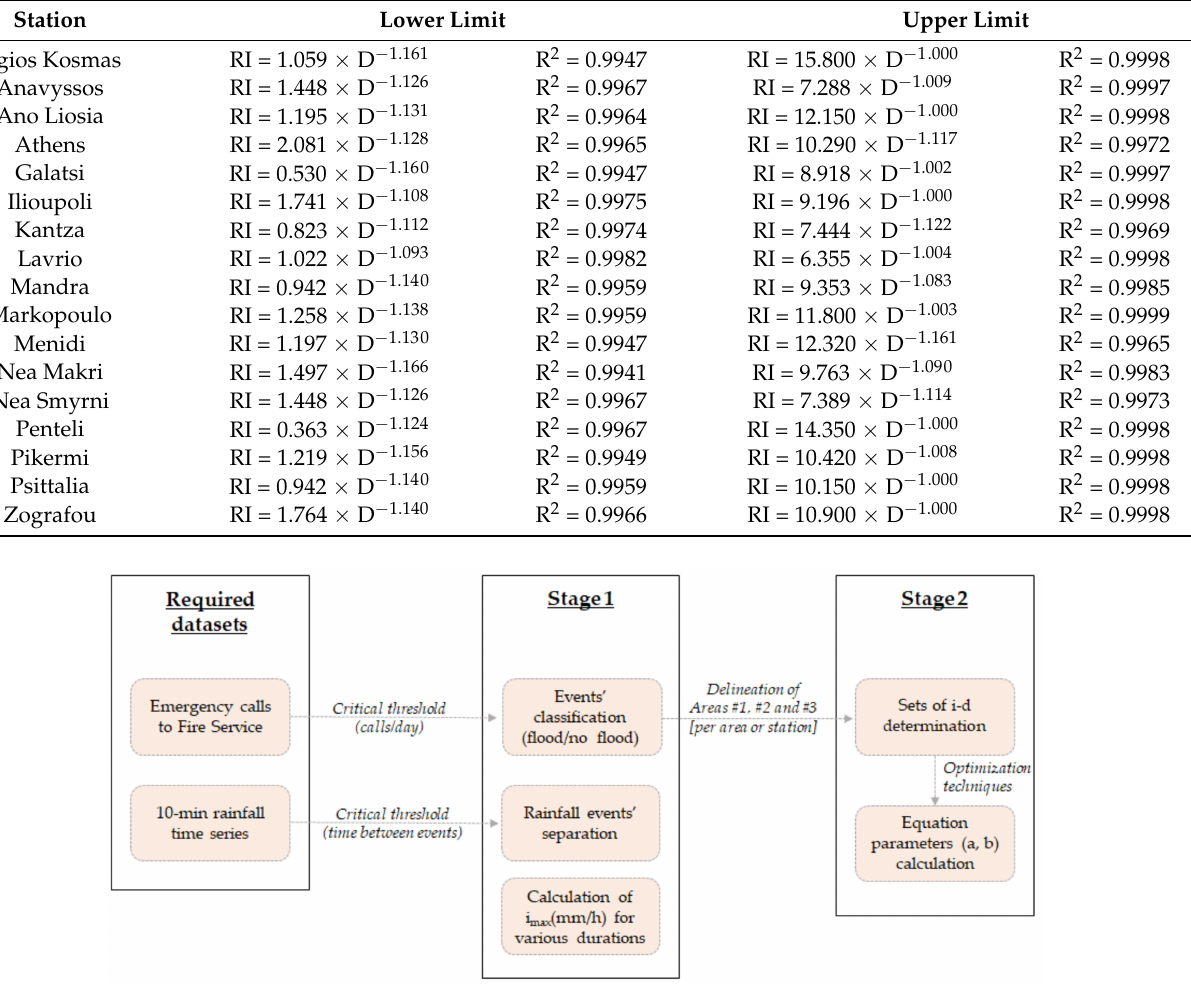
Figure 3. Summary of the methodological